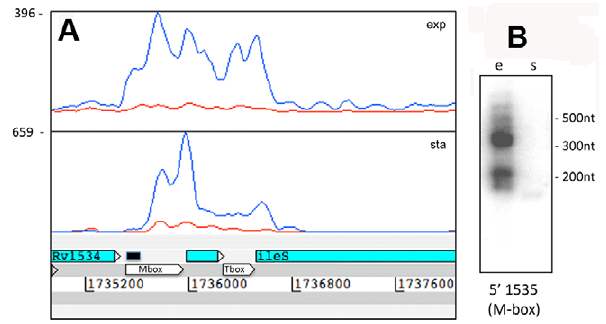
Figure 6. Rv1535 is flanked by two riboswitches. The region between Rv1534 and Rv1536 ( ileS, isoleucyl-tRNA synthase) is predicted to contain two riboswitches; an Mbox upstream of Rv1535 and a T-box upstream of ileS . The intervening open reading frame, Rv1535, is annotated as expressing a hypothetical protein with unidentified homology or function. Panel A shows Artemis expression profiles and panel B illustrates Northern blot analysis in exponential (‘‘e’’) and growth stationary phase (‘‘s’’), using the probe indicated by a black bar above the Mbox. Riboswitch expression is evident in the form of short RNA transcripts with a more downstream start site in stationary phase.